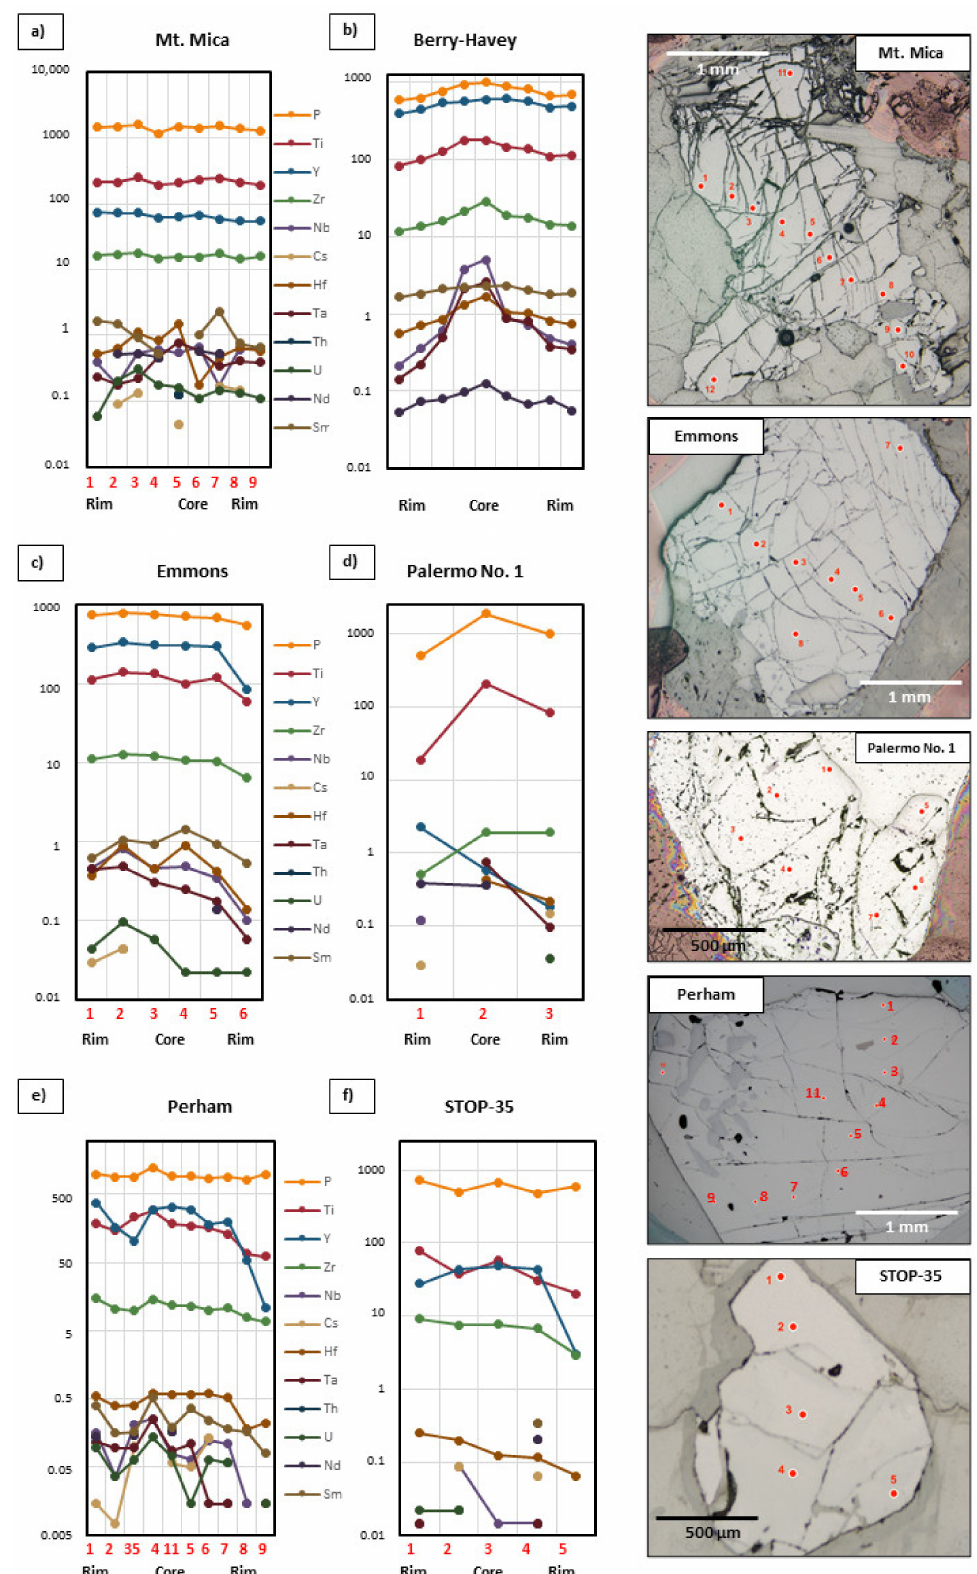
Figure 15. Trace element zoning diagrams. On the right side are shown the photomicrographs of the analyzed points in each garnet of the fractionated pegmatites ( a – c ), intermediate pegmatite ( d ); and barren pegmatites ( e , f